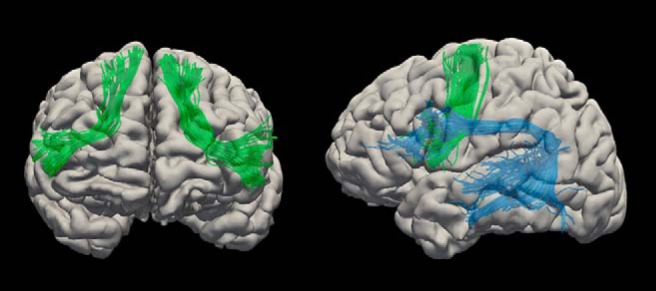
The arcuate fasciculus (blue) and frontal aslant tract (green).